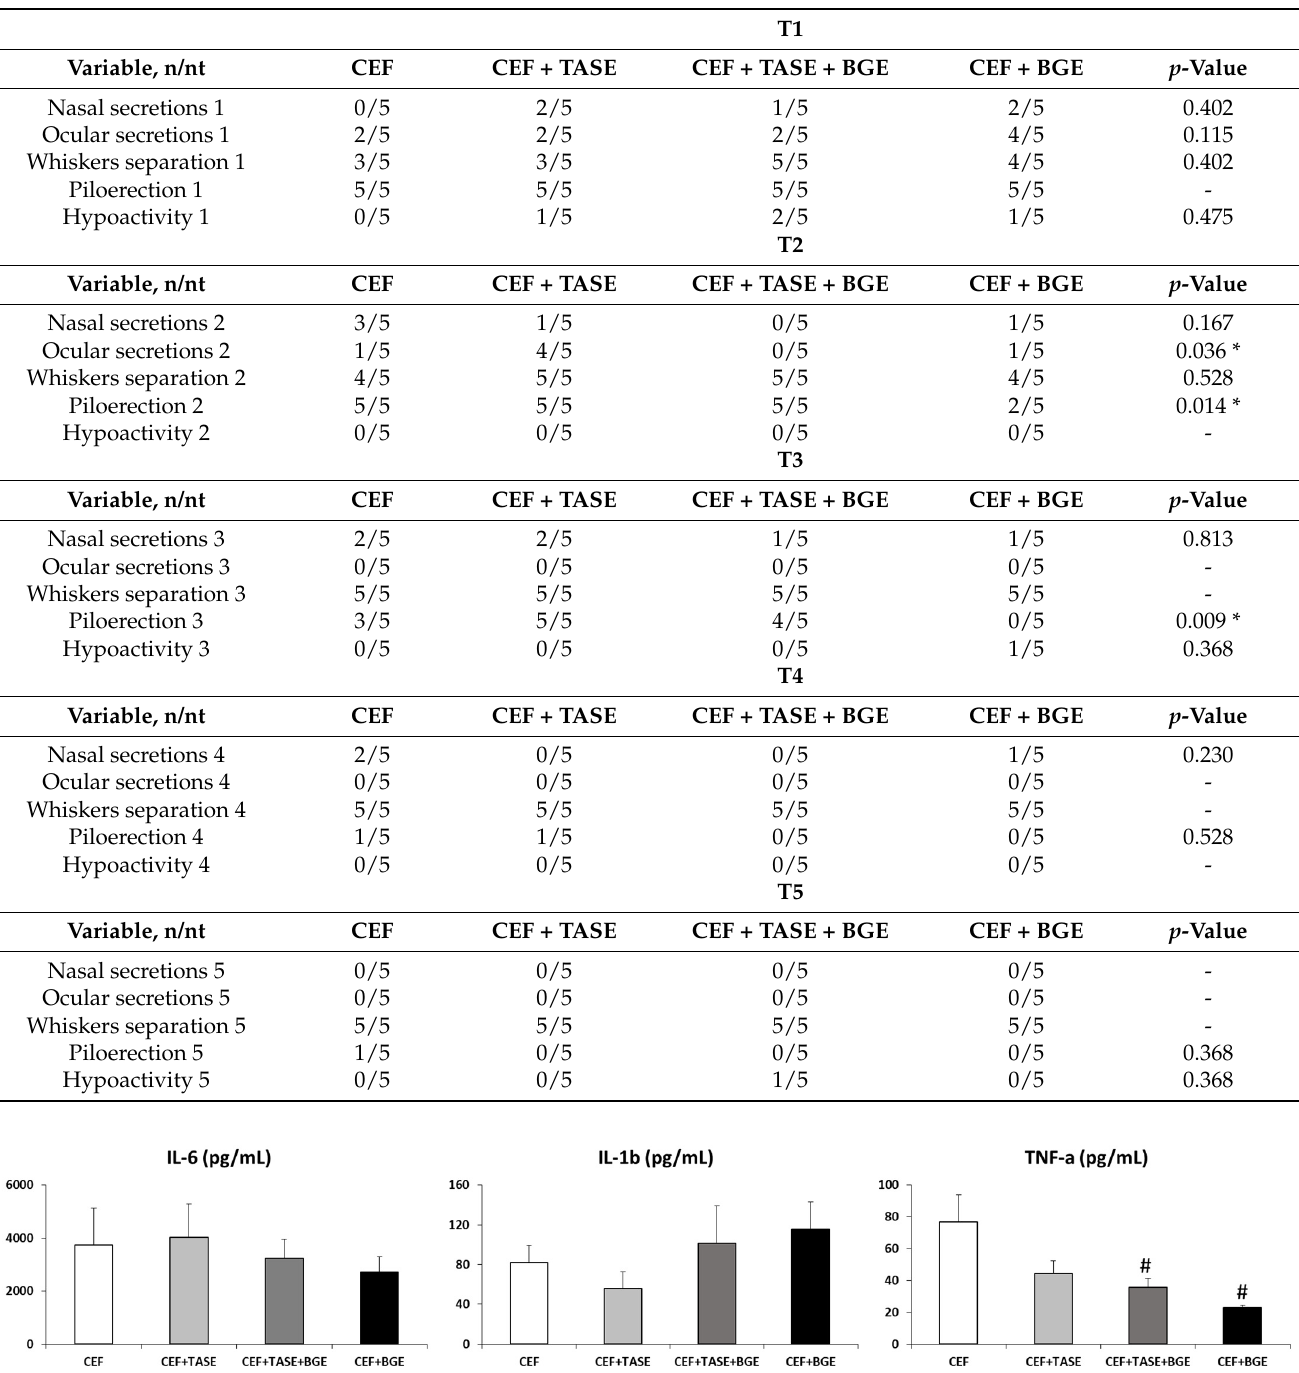
Figure 3. Interleukin levels in T2 (treatment day 2). CEF = ceftriaxone. CEF + TASE = ceftriaxone + thiosulfinate-enriched Allium sativum extract. CEF + TASE + BGE = ceftriaxone + thiosulfinate-enriched extract + black garlic extract. CEF + BGE = ceftriaxone + black garlic extract. Mean ± SEM. # p < 0.05.